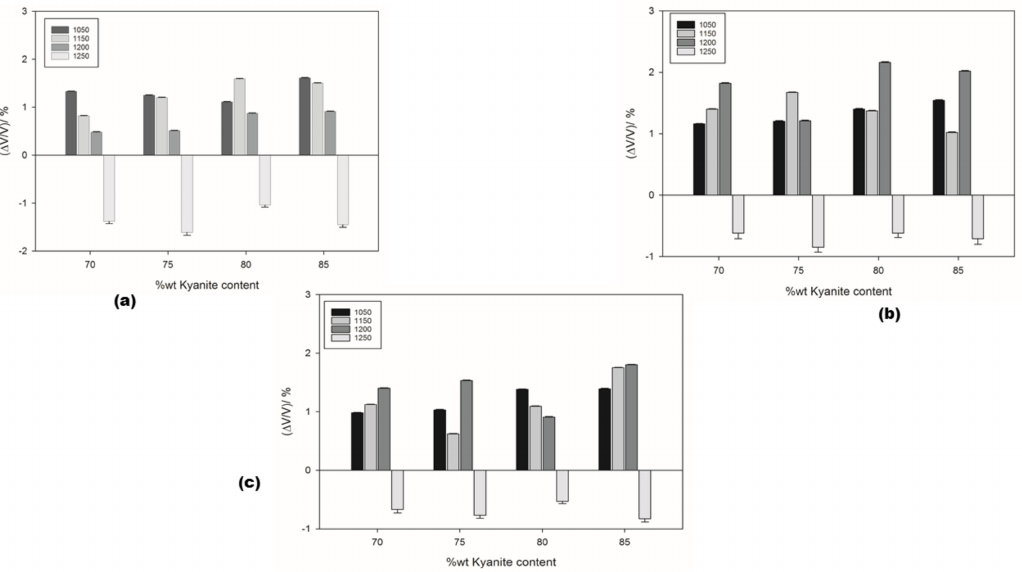
Figure 2. Dimensional stability under sintering cycles: ( a ) RB series; ( b ) RC series and ( c ) RD series.